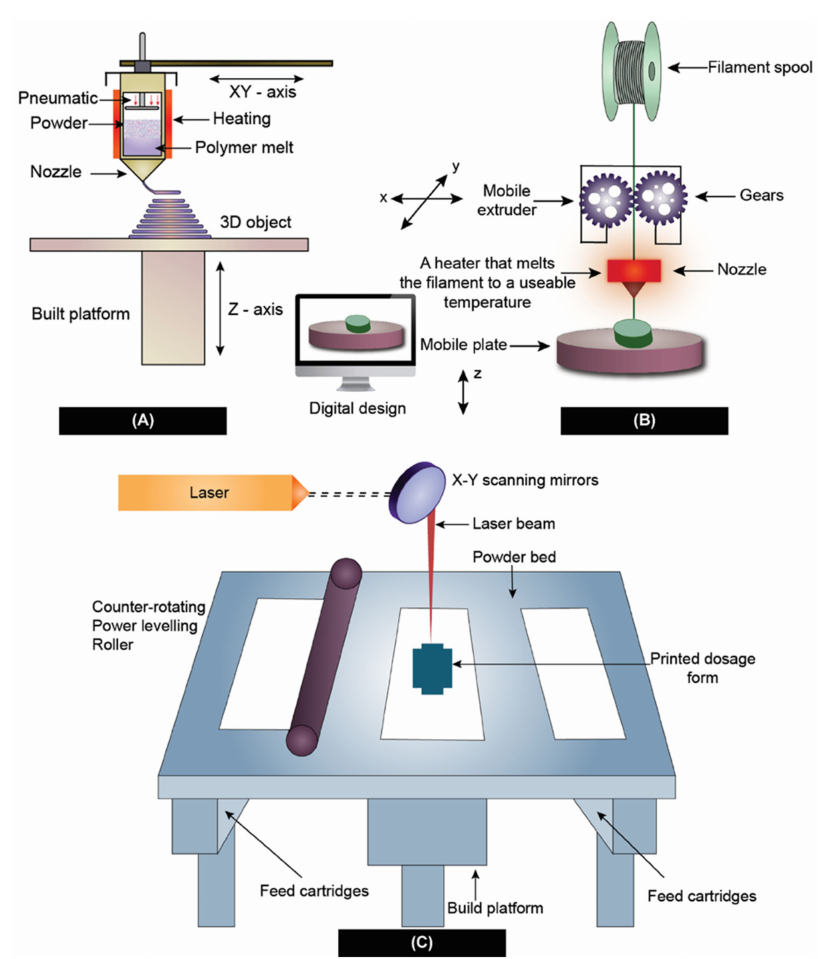
Figure 4. 3D-printing techniques used in the preparation of ASD. ( A ) Direct powder extrusion, ( B ) Fused deposition modeling, and ( C ) Selective laser